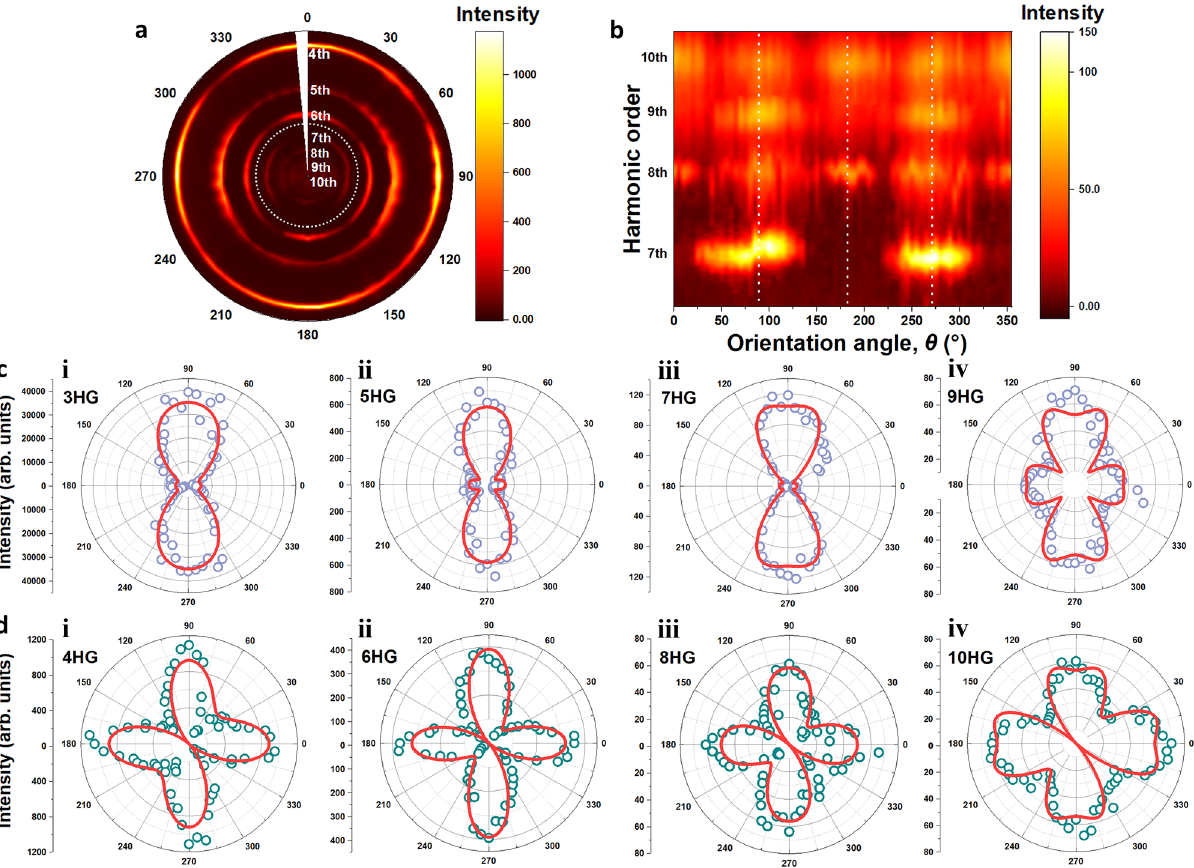
Fig. 4 Dependence of the high-harmonic yield from β -WP 2 on pump orientation. a False-color map of the crystallographic orientation-dependent HHG spectra. Zero degrees corresponds to the pump polarization parallel to the a -axis ( Γ – X direction in reciprocal space). The pump intensity was set as ~0.9 TW/cm 2 at a wavelength of 1900 nm in the experiment. b Zoomed-in view of the section of the 7th – 10th harmonics surrounded by dashed circles in ( a ). Vertical lines highlight angles of 90°, 180°, and 270°. c , d Polar plots of the respective orientation-dependent strength of odd and even orders. Red lines are the fi tting results obtained from Eqs. (5) and